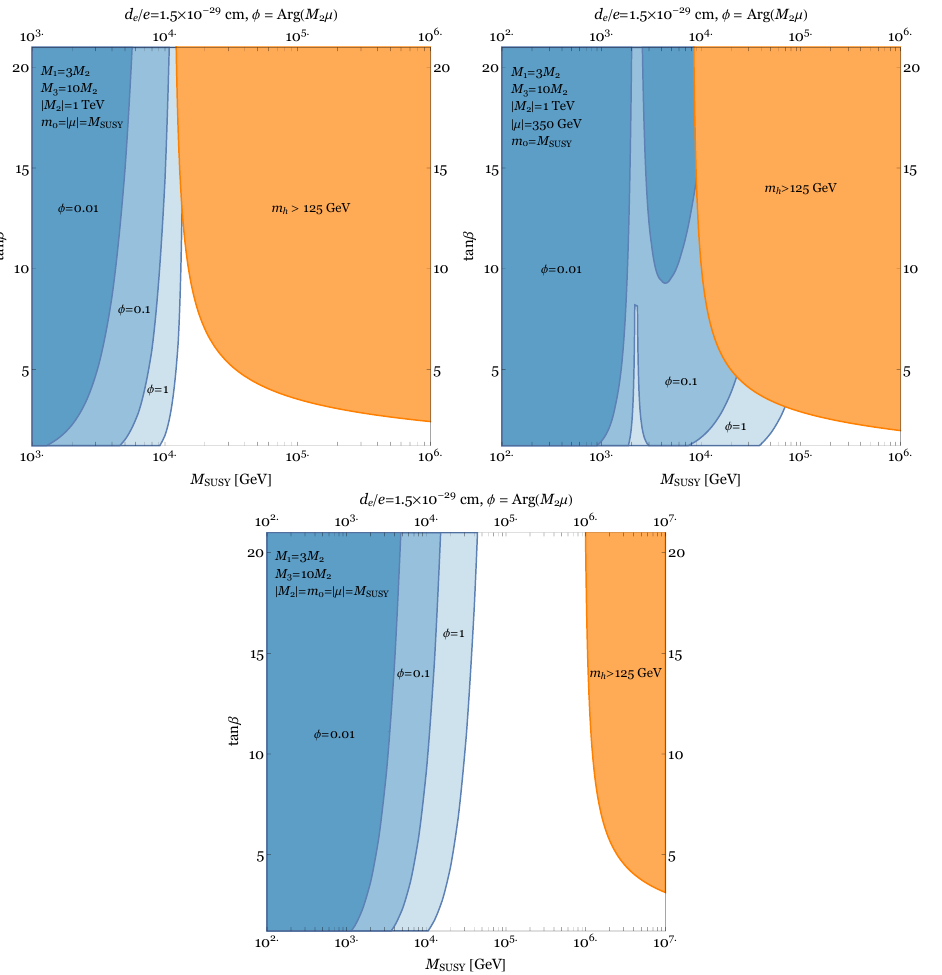
Figure 4 . The ACME II constraint on M SUSY and tan (cid:12) . The electron EDM is generated by the right diagram of (cid:12)gure 1. The orange region is excluded from m h > 125 GeV. The upper left and right panels correspond to the case of split SUSY, M 1 ; 2 ; 3 m 0 = M SUSY . We take (cid:22) = M SUSY (cid:28) j j and (cid:22) = 350 GeV in the left and right panels respectively. The lower panel corresponds to the j j case of high-scale SUSY, M 1 ; 2 ; 3 m 0 = M SUSY . In all cases, we assume a gaugino mass ratio, M 1 : (cid:24) M 2 : M 3 = 3 : 1 : 10. In each panel, we plot three cases of the phase (cid:30) arg( M 2 (cid:22) ) = 1 ; 0 : 1 ; 0 : (cid:17)